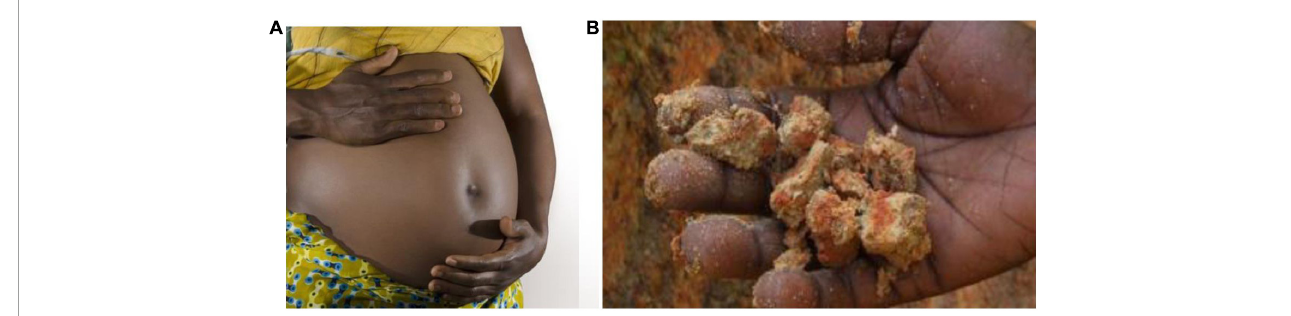
FIGURE2 What are the effects of geophagic practices on the developing foetus? (A) In sub-Saharan Africa, up to 84% of geophagy practitioners in some regions are thought to be pregnant women. Source: MUV (Medical University of Vienna), (15). (B) Geophagic soil consumed by pregnant women on Pemba Island, Zanzibar, a Tanzanian archipelago. Credit: Sera Young, Columbia University Press.